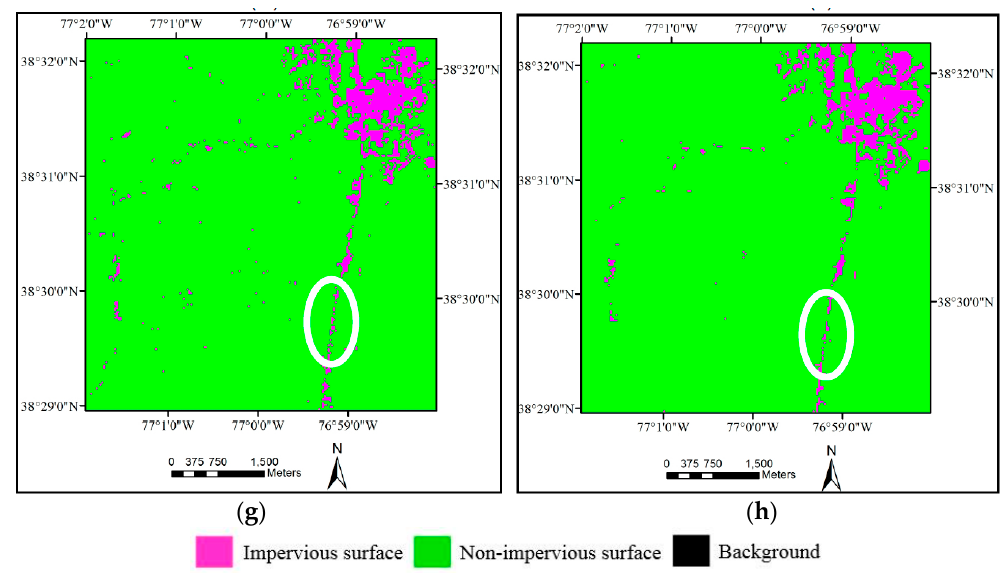
Figure 6. Hyperion dataset 2: ( a ) training data; and ( b ) test data. Estimation maps obtained by: ( c ) SPE-SVM; ( d ) SS-SVM; ( e ) SPE-RF; ( f ) SS-RF; ( g ) SPE-SR; and ( h ) SS-SR.